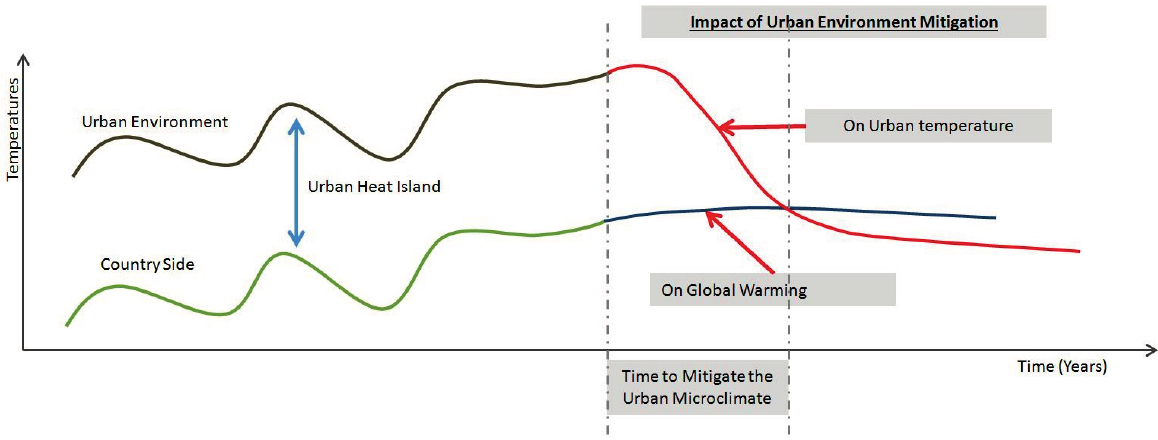
Figure 5. Traditional approach vs. proposed